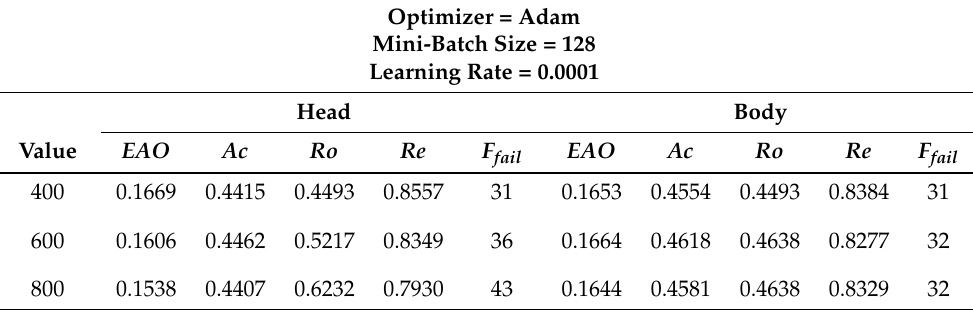
Table 8. Performance evaluations of the number of training